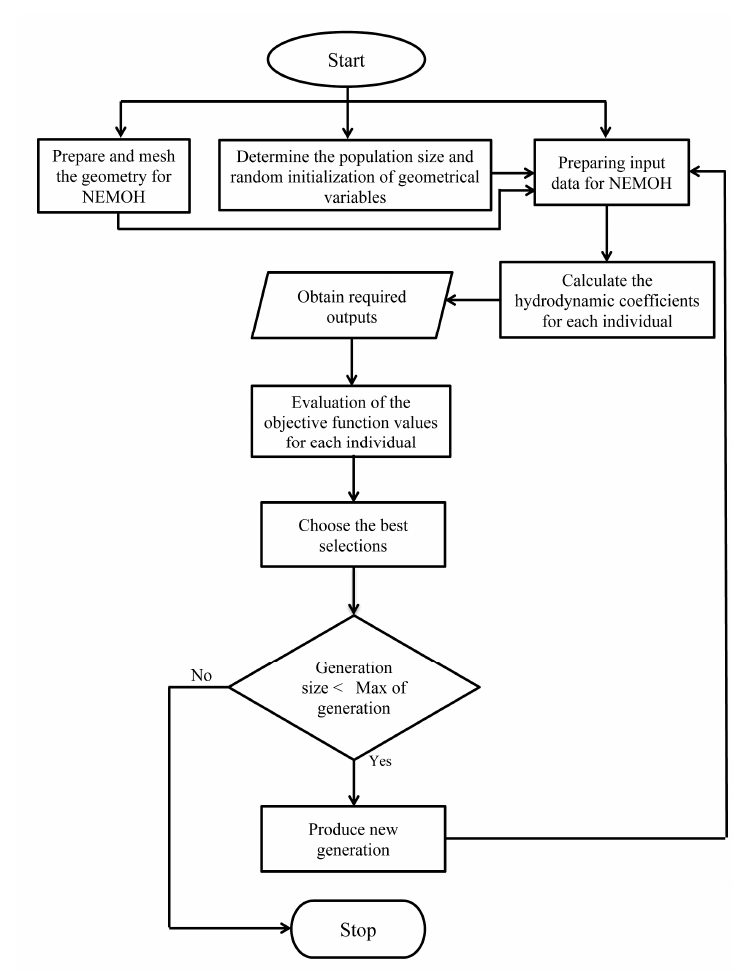
Figure 4. Flowchart of implementing the genetic algorithm for the WEC shape optimization.